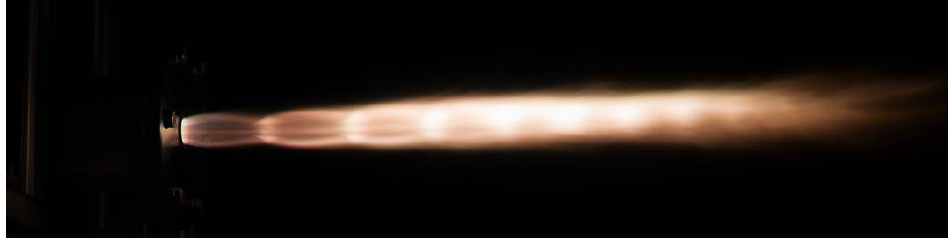
Figure 12. Side view of the jet blast with under expansion form a Monoport geometry.